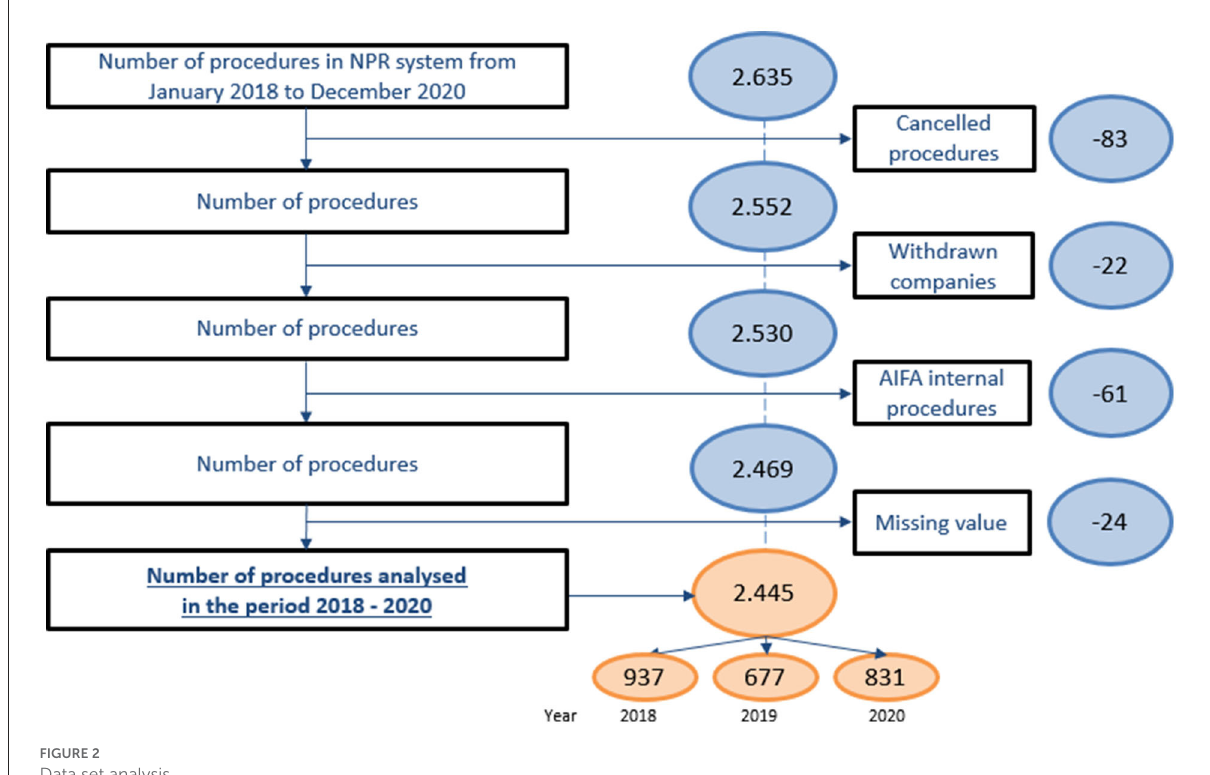
FIGURE2 Data set